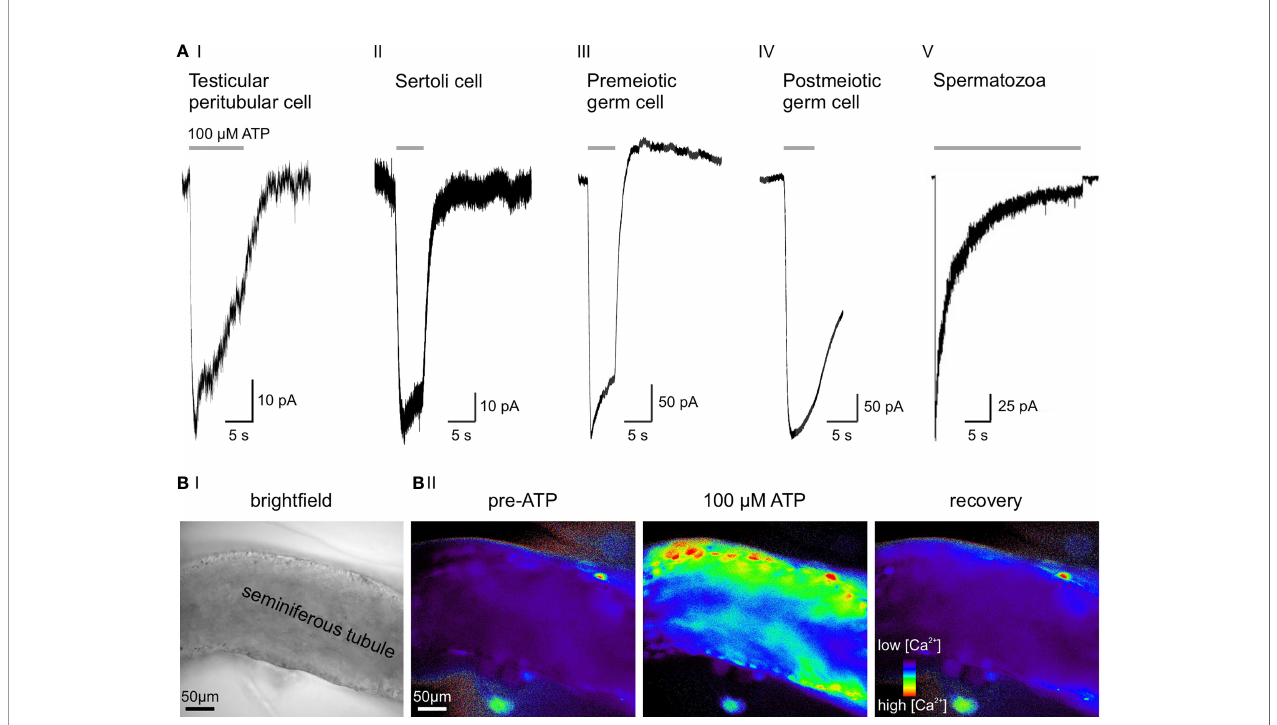
FIGURE 2 | ATP sensitivity across cell types of the seminiferous tubule. (A) Representative whole-cell voltage-clamp recordings from various testicular cell types, transiently exposed to extracellular ATP (100 µM). Negative current indicates cation in fl ux through P2X receptors. (A I ) Slowly desensitizing P2X2 and/or P2X4 current in a mouse TPC (3). (A II ) ATP activates P2X2 in murine Sertoli cells (33). (A III ) 100 µM ATP selectively activates P2X4, but not P2X7 in premeiotic spermatogonia. Note the delayed BK-mediated outward current (33). (A IV ) Postmeiotic germ cells exhibit an ATP-induced inward current, but the underlying P2X isoform is yet to be identi fi ed (unpublished data; recording in an acute seminiferous tubule section from an adult mouse according to (33), extracellular solution containing (mM) 145 NaCl, 5 KCl, 1 CaCl 2 , 0.5 MgCl 2 , and 10 HEPES; pH = 7.3, intracellular solution containing (mM) 143 KCl, 2 KOH, 1 EGTA, 0.3 CaCl 2 , 10 HEPES, and 1 Na-GTP ([Ca 2+ ] free = 110 nM); pH = 7.1, stimulation with 100 m M ATP for 5 s). (A V ) Epididymal mouse spermatozoa with characteristic fast-activating and slowly desensitizing P2X2 current evoked by extracellular ATP. Electrophysiological recording was performed on a head plus midpiece fragment by Navarro et al. (2011) (34). (B) Combined ionotropic and metabotropic ATP responses of various cells in an acute seminiferous tubule section visualized as Ca 2+ -dependent changes in fl uorescence. Imaging was performed according to published experimental protocols (35). (B I ) Bright fi eld micrograph of the seminiferous tubule section under investigation. (B II ) Fluorescence images of the same seminiferous tubule bulk-loaded with fura-2/AM (30 m M, 30 min at room temperature). Pseudocolor images (rainbow 256 color map) illustrate relative cytosolic Ca 2+ concentration before, during, and after ATP stimulation (unpublished